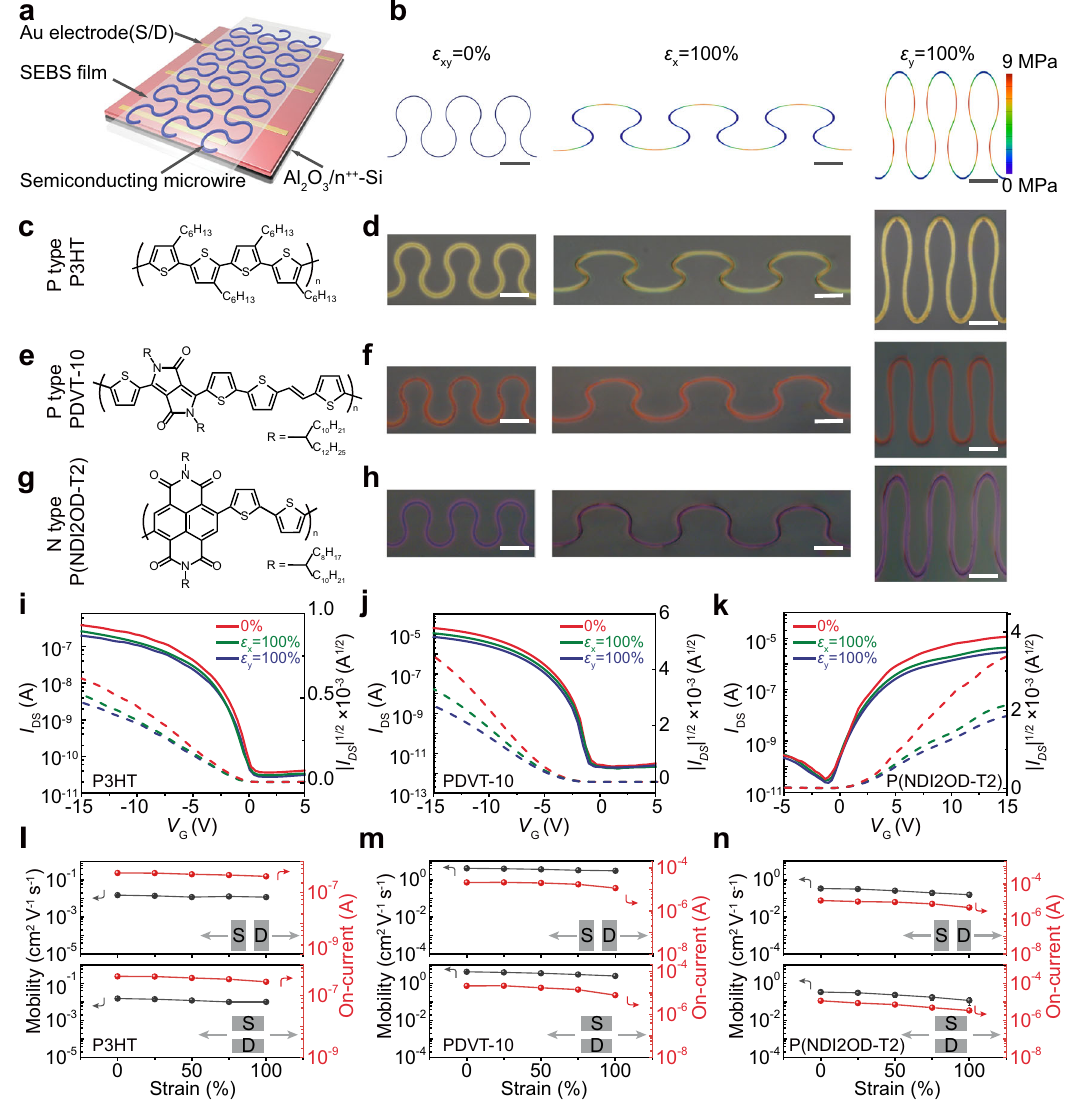
Fig. 2 Stretchability of polymer curvilinear microstructures. a Scheme of the FET device based on curvilinear polymers microstructures. The electronic performance of curvilinear polymer microstructures was measured by the soft contact lamination method. b Finite element analysis of the deformable curvilinear P3HT microstructure arrays on SEBS substrate in the unstretched state ( ε xy = 0%) and under 100% strain parallel ( ε x = 100%) and perpendicular ( ε y = 100%) with the charge transport direction, respectively. Chemical structures of two typical P-type polymers c P3HT and e PDVT-10, and an N-type polymer ( g ) P(NDI2OD-T2). d , f , h Optical images of the deformable curvilinear microstructures based on polymers of ( c ), ( e ), and ( g ) on SEBS substrate in the unstretched state (left) and at 100% strain parallel (middle) and perpendicular (right) to the charge transport direction, respectively. i – n Transfer curves and the statistical diagrams of the on-current and mobility of these polymer OFETs at 0% strain and 100% strain parallel and perpendicular to the charge transport direction, respectively. Solid and dashed lines in ( i ) – ( k ) are I DS – V GS and | I DS | 1/2 – V GS curves of devices, respectively. The mobilities in ( l ) – ( n ) represent average values are obtained from fi ve devices. All scale bars: 10 μ achieved under 100% strain (Fig. 2l – n), indicating the robust for detailed discussion). The optical micrographs demonstrate the stretchability of these curvilinear microstructures.